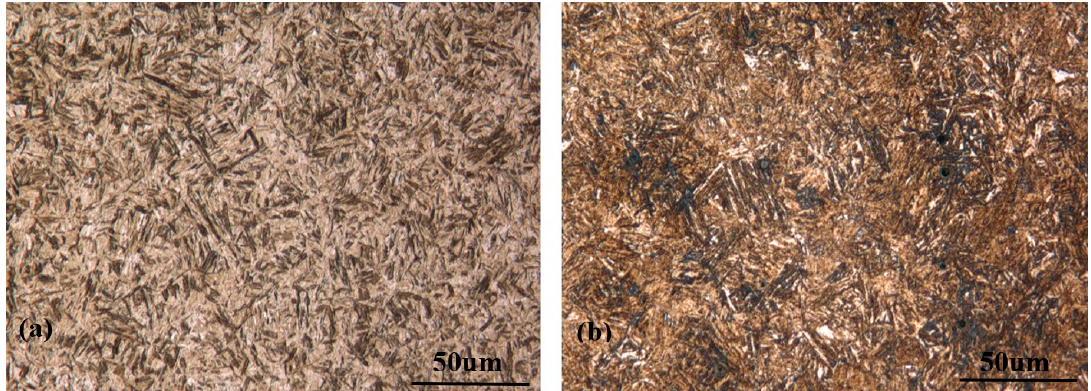
Figure 7. Microstructure of the 4140 steel consisted of lower bainite and martensite. Isothermal heat treatment at 315 °C for 60 s ( a ) and for 300 s ( b ).